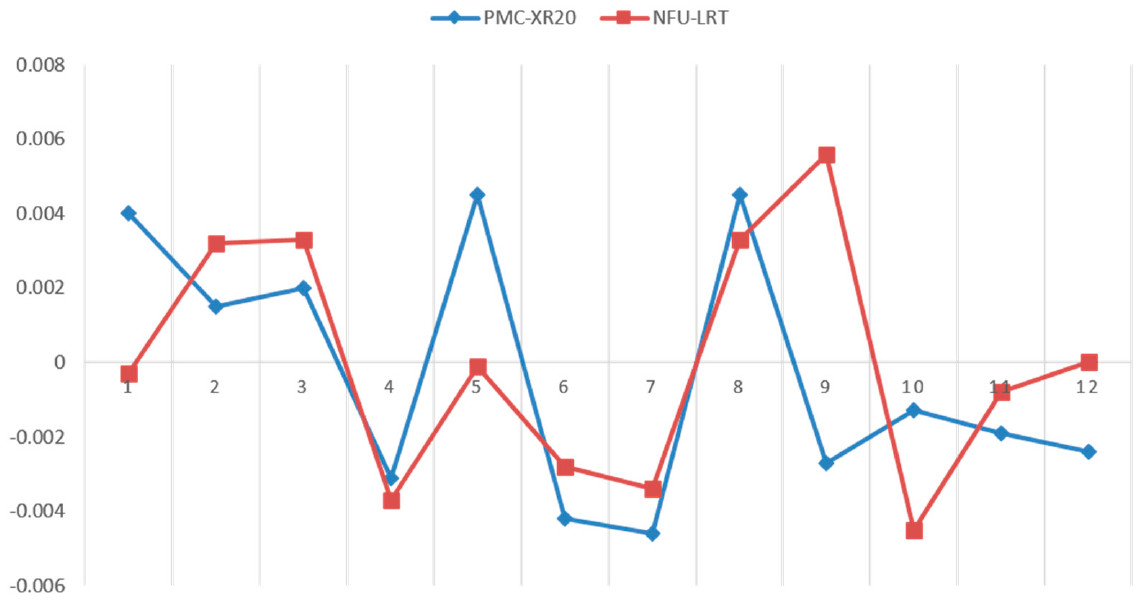
Figure 30. Comparison of the error result between two systems.